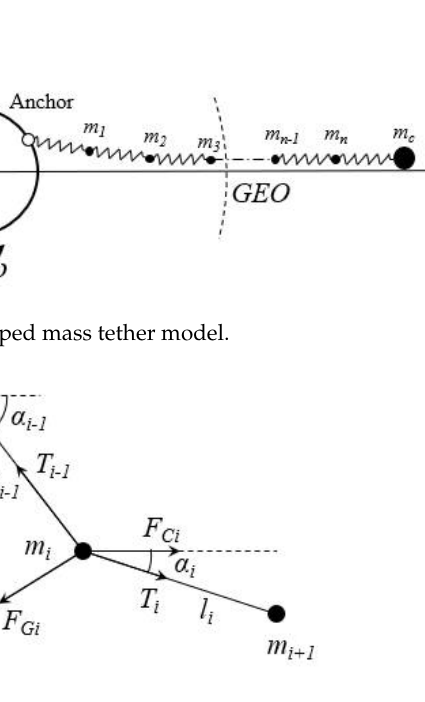
Figure 4. Forces acting on the